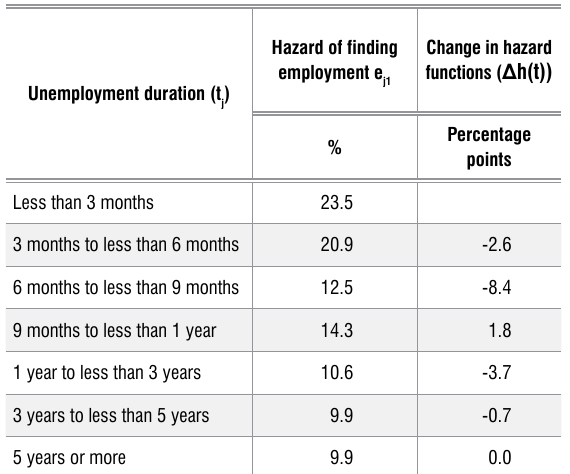
Change in hazard functions for each unemployment duration